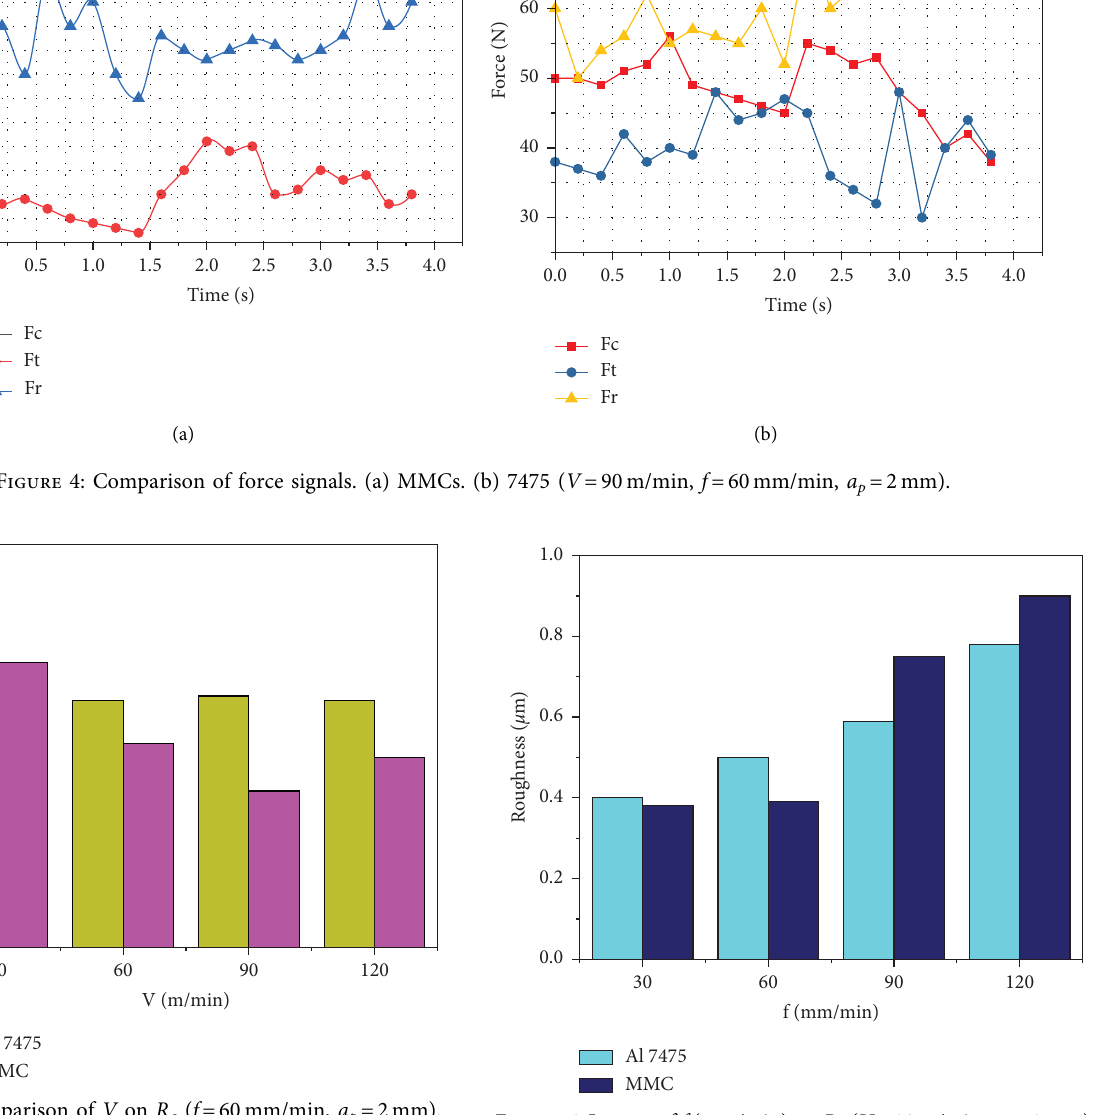
6: Impact of f (mm/min) on R a ( V � 90m/min, a p � 2